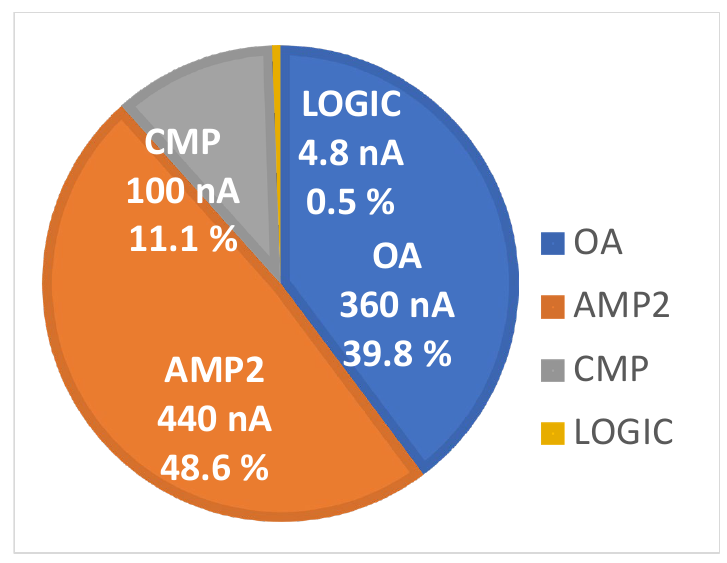
Figure 17. Breakdown of current consumption in SAM.